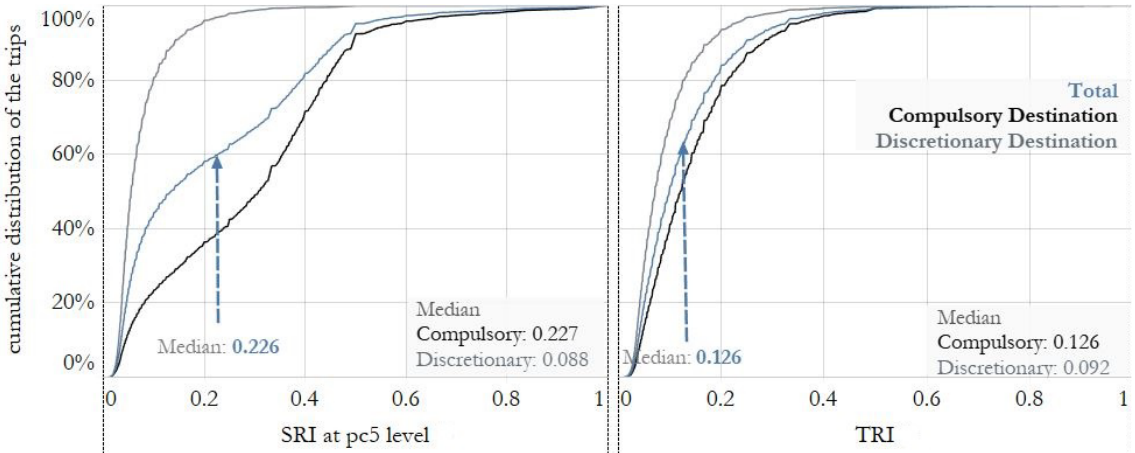
Figure 2. Distribution of SRI and TRI